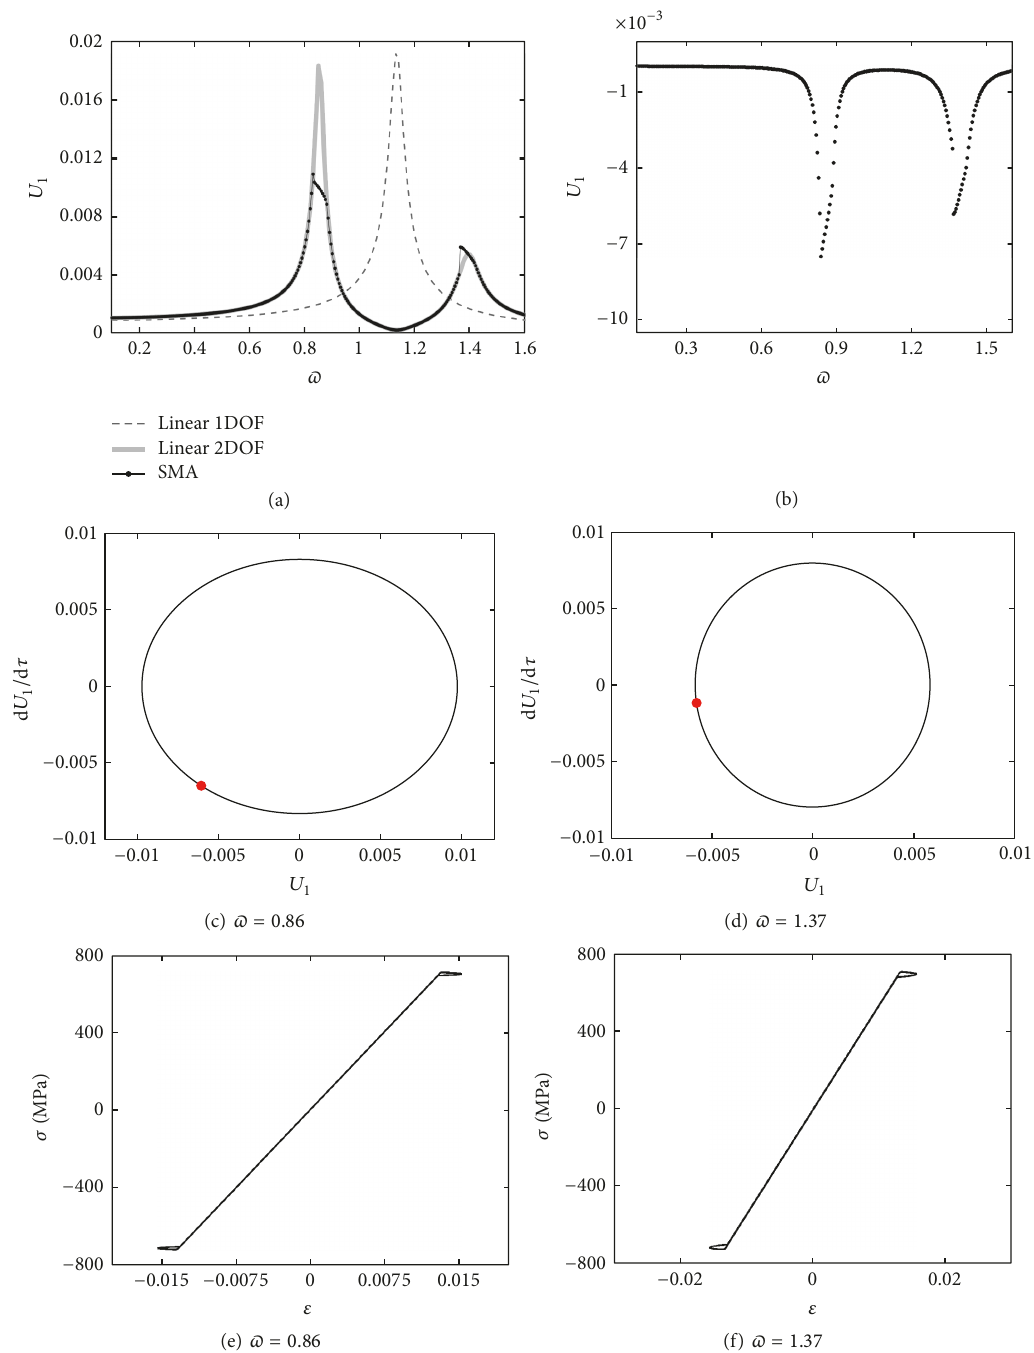
Figure 2: Primary system response with 𝛿 = 0.0011 and 𝛾 𝑚 = 0.22 in up-sweep test: (a) maximum amplitude; (b) bifurcation diagram; (c-d) phase space with Poincar´e section; (e-f) stress-strain